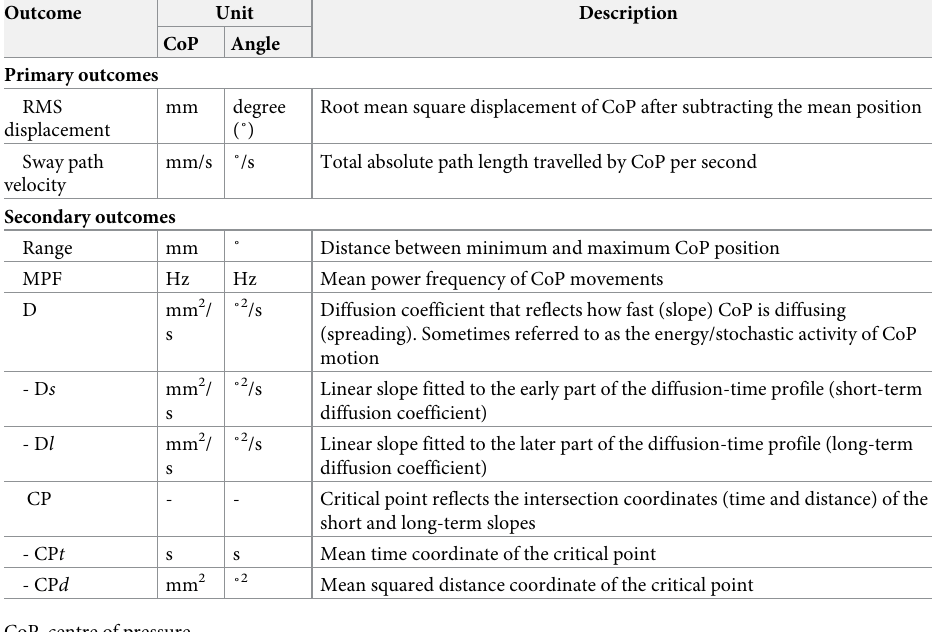
Table 2. Postural outcome measures in anteroposterior or mediolateral